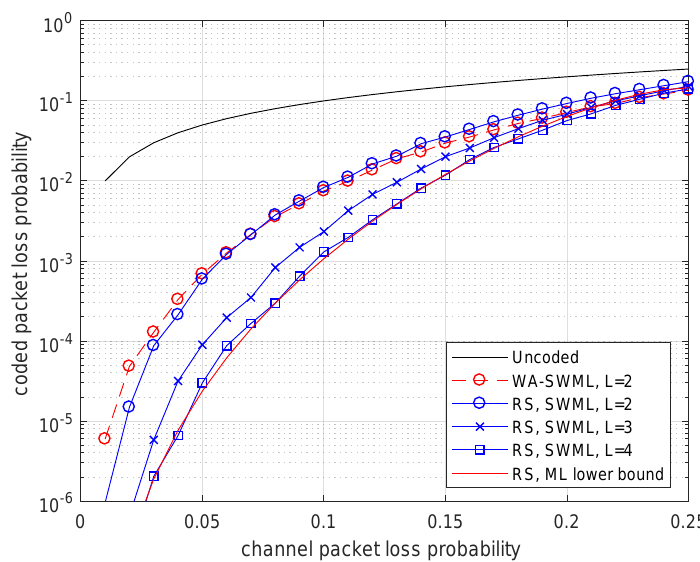
Figure 5. Comparison of the binary Wyner–Ash code and the RS convolutional code of rate R = 3/4.